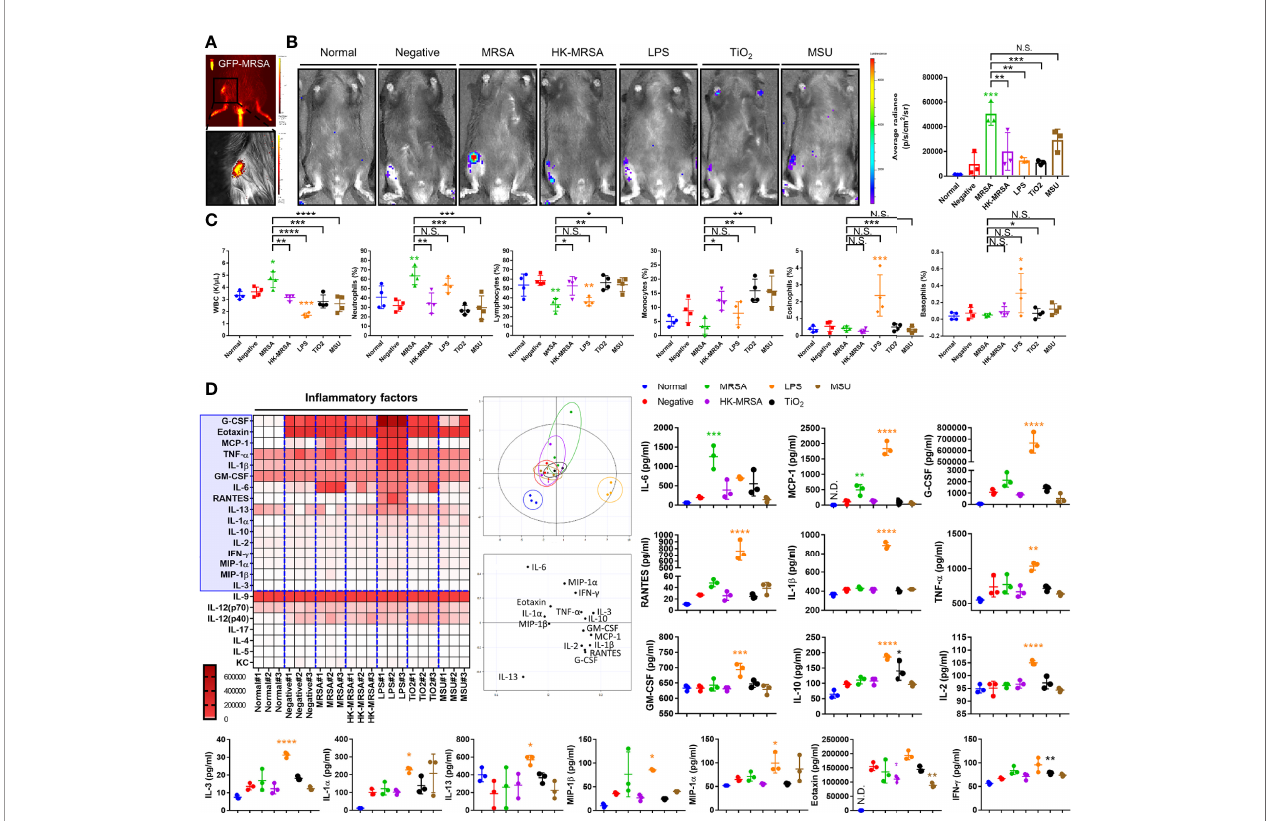
FIGURE 1 | Variation in immunologic and in fl ammatory responses between in fl ammatory arthritis caused by infectious and non-infectious sources. (A) Successful intraarticular knee injection was veri fi ed by measuring the intensity of GFP immediately after administration of MRSA constitutively expressing GFP. (B – D) C57BL/6 mice were injected with MRSA (1×10 5 CFU/10 m L), HK-MRSA (1×10 5 CFU/10 m L), LPS (200 µg/mL), TiO 2 (3 mg/mL), and MSU (200 µg/mL) into the knee joint space, with DPBS injection used as a negative control ( n = 3-4 per group). (B) One day after injection, the generation of in fl ammation in the knee joint was assessed through measurement of MPO activity. (C) The total blood cell count and percentage of neutrophils, lymphocytes, monocytes, eosinophils, and basophils were measured using CBC analysis. (D) The generation of systemic in fl ammatory mediators, including cytokines, chemokines, and growth factors, was measured in serum and analyzed using principal component analysis; proteins that display signi fi cant variation in expression are highlighted within the blue box. Error bars show means ± SD. One-way ANOVA with Tukey ’ s post hoc analysis was used to assess statistical signi fi cance when compared to the negative control group or MRSA group (* p <0.05 or ** p < 0.01 or *** p < 0.001 or **** p < 0.0001; N.D., not detected and N.S., not signi fi